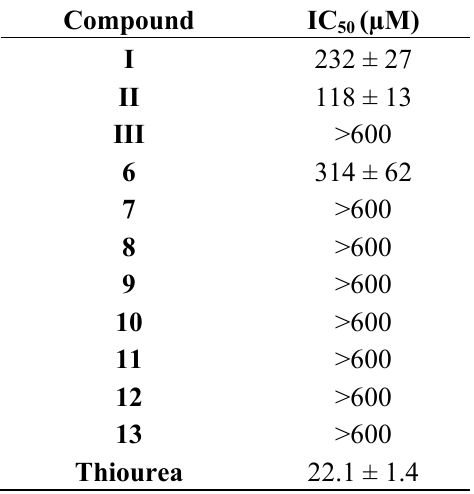
Table 3. Inhibitory activity IC against jack bean